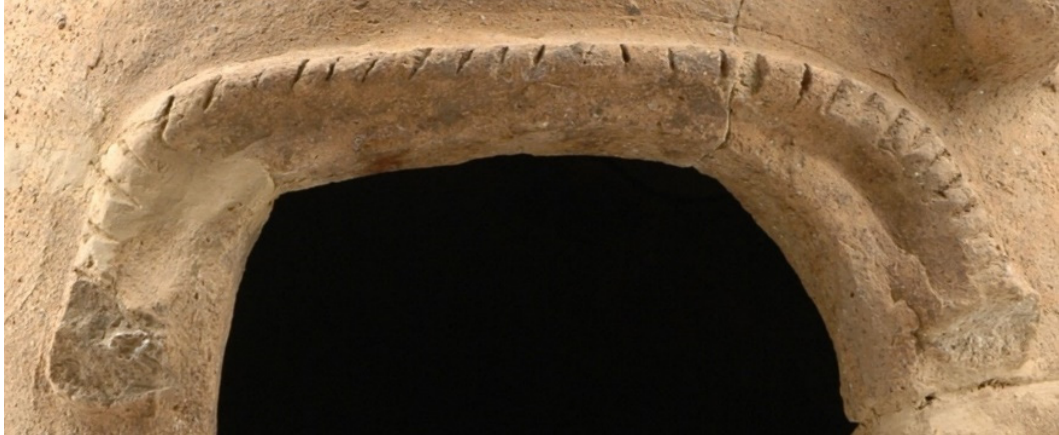
Figure 10. Close-up of the clay ribbon above the door of the portable shrine from Tel Rehov (courtesy of Amihai Mazar, photograph by D. Harris).